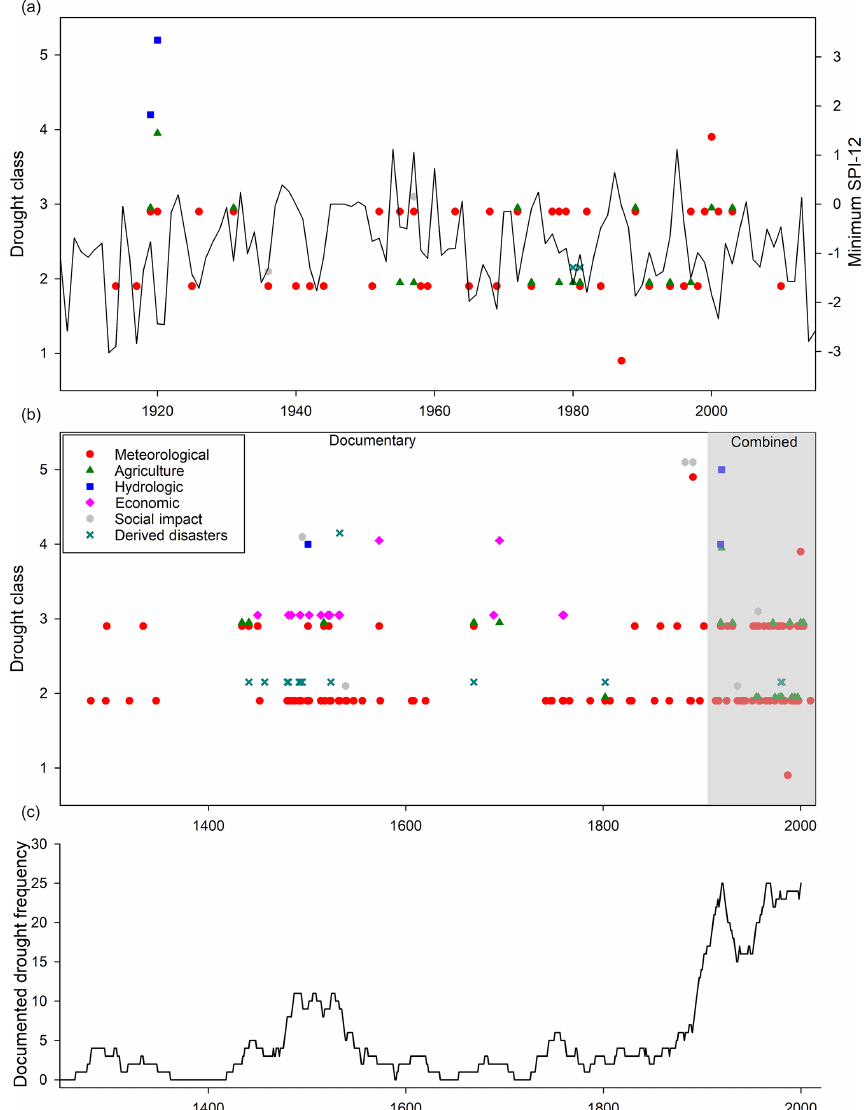
Figure 6. Shenyang drought classification (colour/shape) for (a) combined archival and instrumental period (1906–2015) with minimum annual SPI-12, (b) augmented period (1200–2015), and (c) a running 30-year mean drought frequency